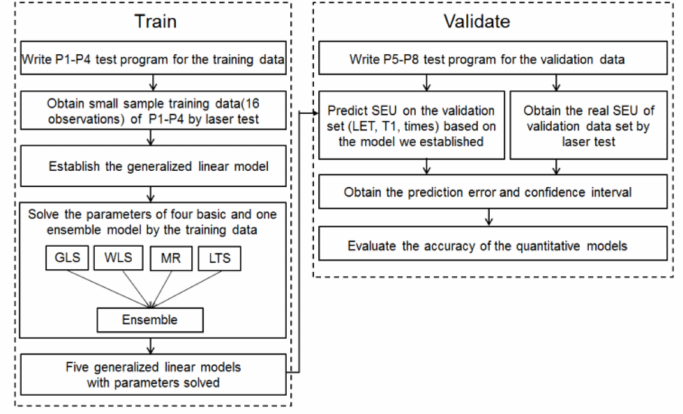
Figure 3. The flow chart of the